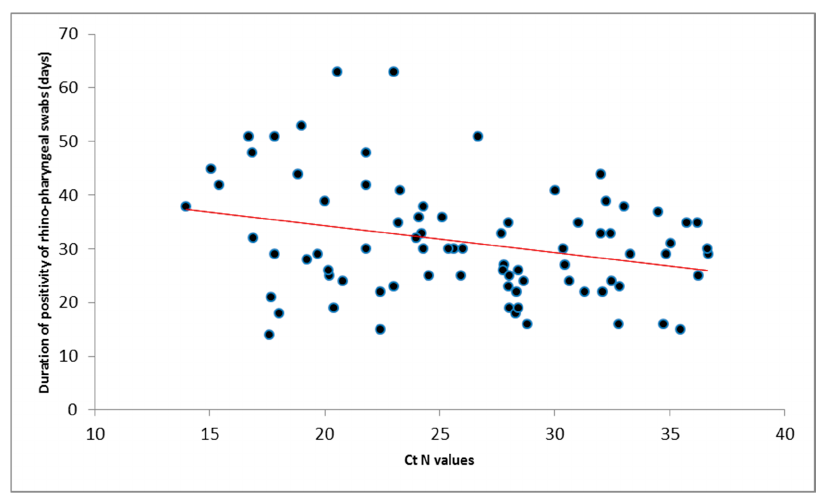
swabs in the same patient, overall and by gender. *Asterisks are denoting the significant values.